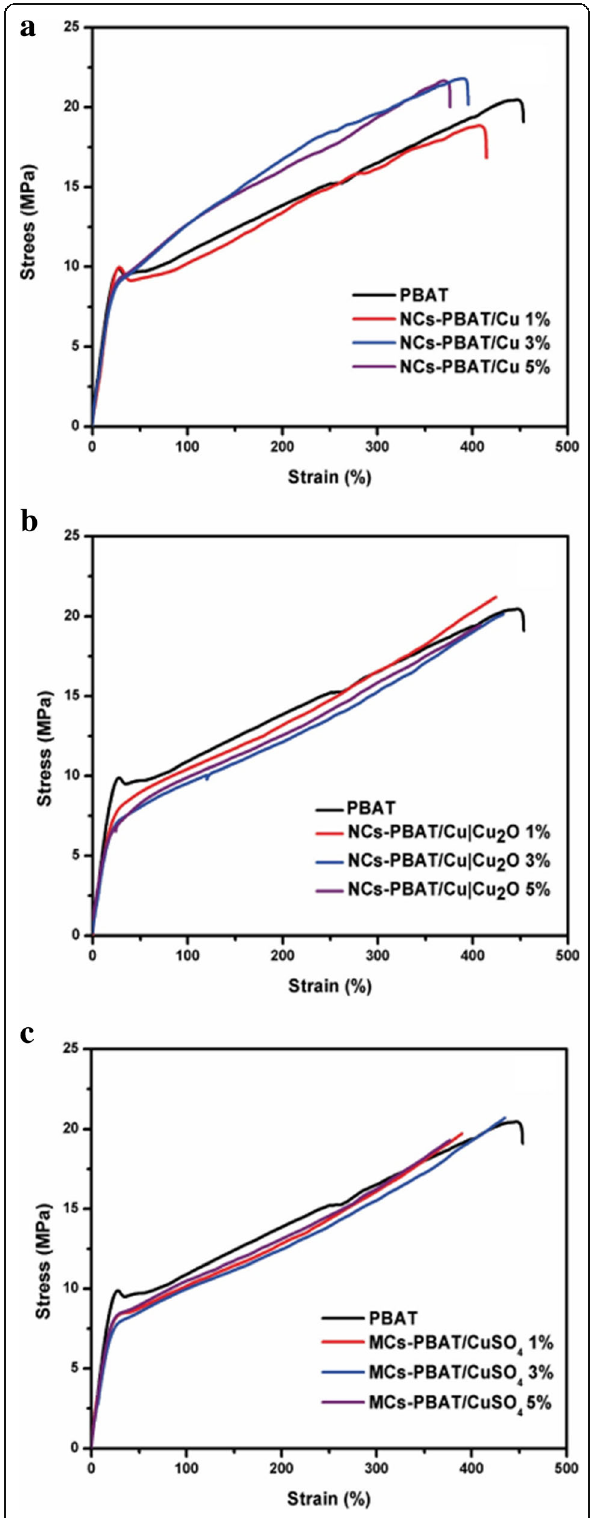
Fig. 3 Stress and strain of PBAT, NCs-PBAT/Cu, NCs-PBAT/Cu|Cu 2 O, and MCs-PBAT/CuSO